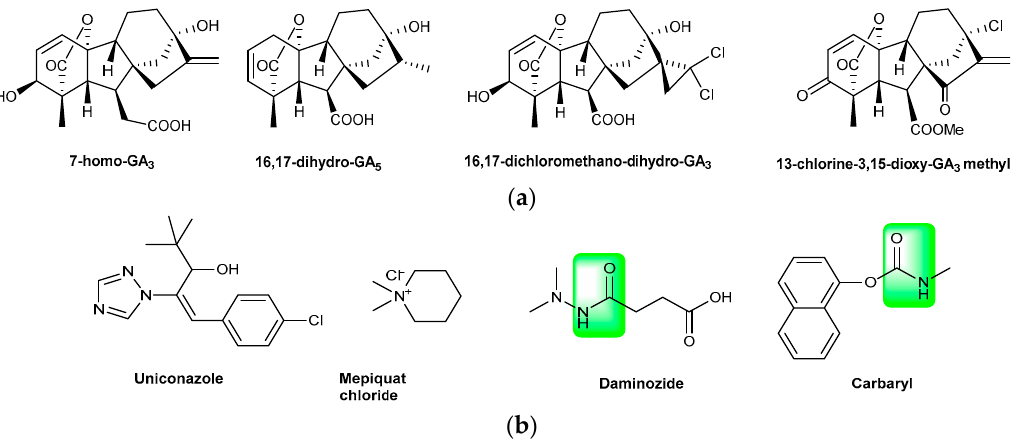
Figure 1. Gibberellic acid (GA 3 ) derivatives ( a ) and commercially available synthetic plant growth regulators (PGRs) ( b ).